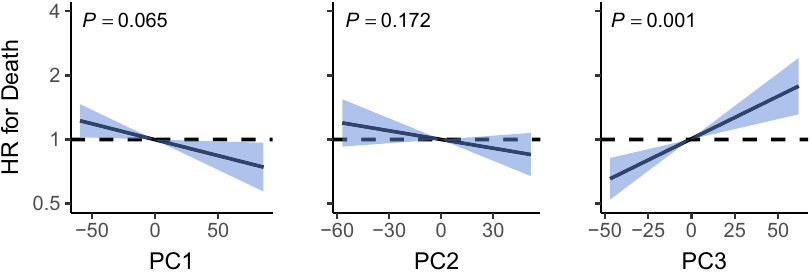
Fig. 2 Principal components and mortality risk. Association between mortality risk and the fi rst three principal components of beta diversity (PC). Black line indicates the estimated hazard ratio compared to median PC value and blue area the 95% con fi dence interval (CI). Unit variance increase in the PCs were related to hazard ratios of 0.92 (95% CI, 0.85 – 0.99; FDR-adjusted P = 0.065; two-tailed Wald test), 0.95 (95% CI, 0.87 – 1.02; FDR-adjusted P = 0.17; two-tailed Wald test) and 1.14 (95% CI, 1.07 – 1.23; FDR-adjusted P = 0.001; two-tailed Wald test) for PC1 – PC3, respectively. Analyses are adjusted for age, body mass index, sex, smoking, diabetes, use of antineoplastic and immunomodulating agents, systolic blood pressure and self-reported antihypertensive medication. The dashed line represents a hazard ratio of 1 set at median PC value. HR hazard host covariates alone. Microbiome features were informative of mortality risk but did not bring in additional performance gains over host covariates.